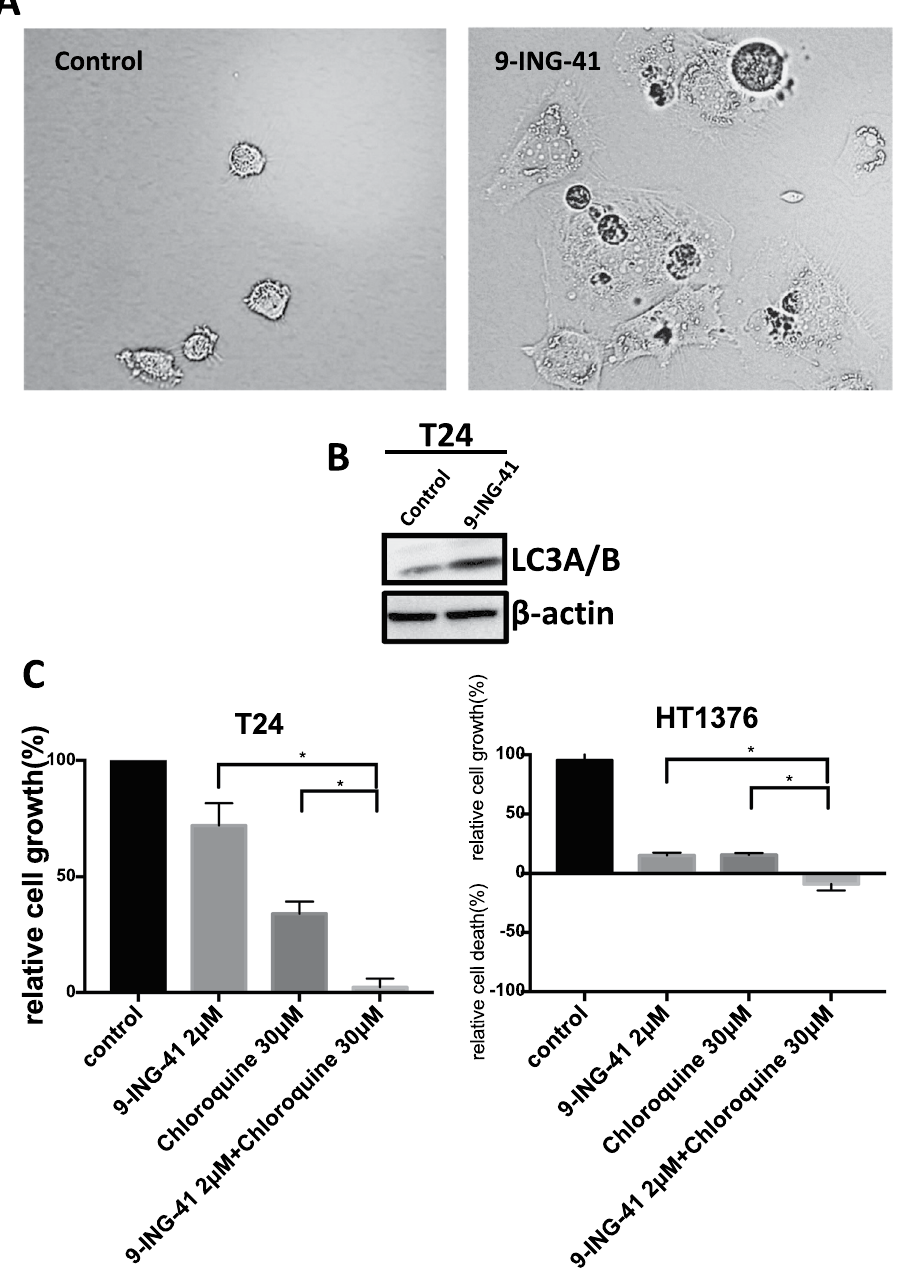
Figure 3. Inhibition of autophagy potentiates the antitumor effects of 9-ING-41 in bladder cancer cells. ( A ) Brightfield images of T24 cancer cells treated with Vehicle (Control) and 9-ING-41 5 μ M for 24 hours. ( B ) T24 bladder cancer cells were treated with 9-ING-41 10 μ M for 48 hrs. Post-treatment, whole cell lysate was prepared from the cells, separated by SDS-PAGE (20 μ g/well), transferred to PVDF membrane, and immunoblotted as indicated. ( C ) Relative cell growth was measured by MTS assay in bladder cancer cell lines T24 and HT1376 treated with 9-ING-41 in combination with autophagy inhibitor chloroquine for 72 hours as indicated. Columns, mean; bars, SD. * P < 0.05 by one-way ANOVA with Tukey post-hoc